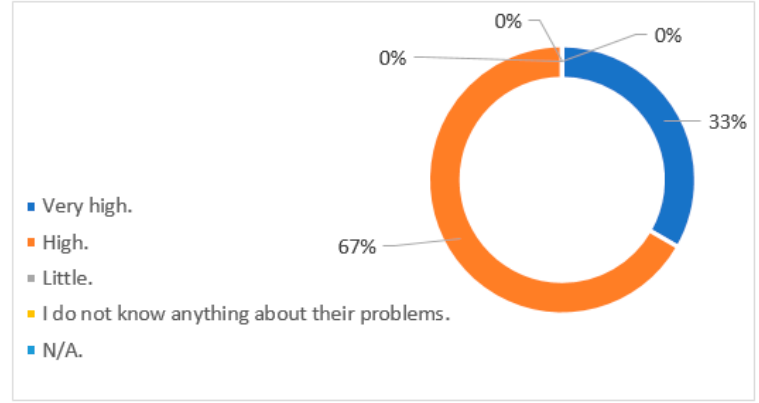
Figure 1. Knowledge about the difficulties of people with disabilities. Table 3. Experience in contact with people with disabilities (check one or more). Answer Result People with disabilities in my family. 33% People with disabilities among my friends. 67% People with disabilities in my neighborhood.